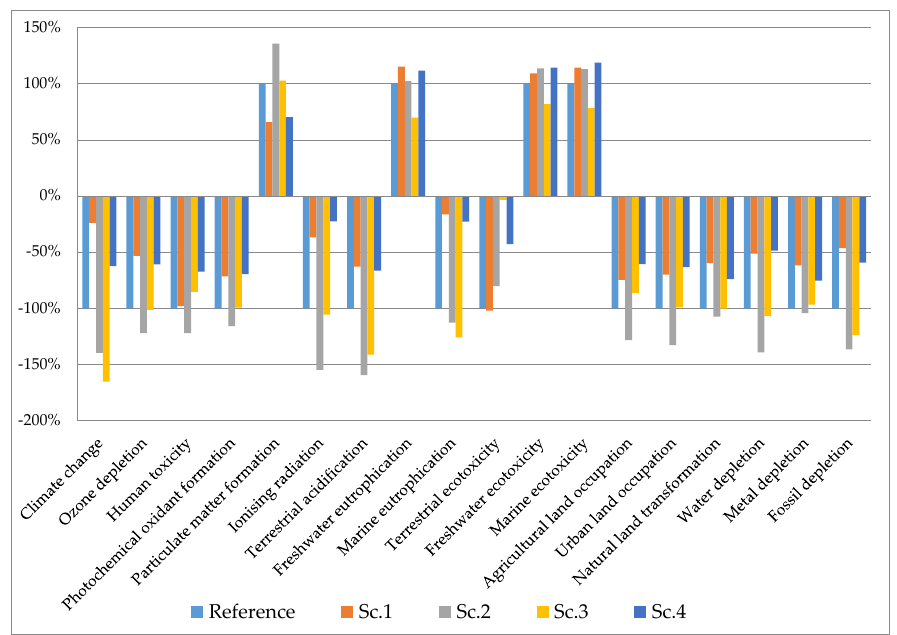
Figure 2. Relative environmental impacts of the waste treatment system (including avoided burdens) for the four base scenarios compared to the reference scenario set to 100% (average data).